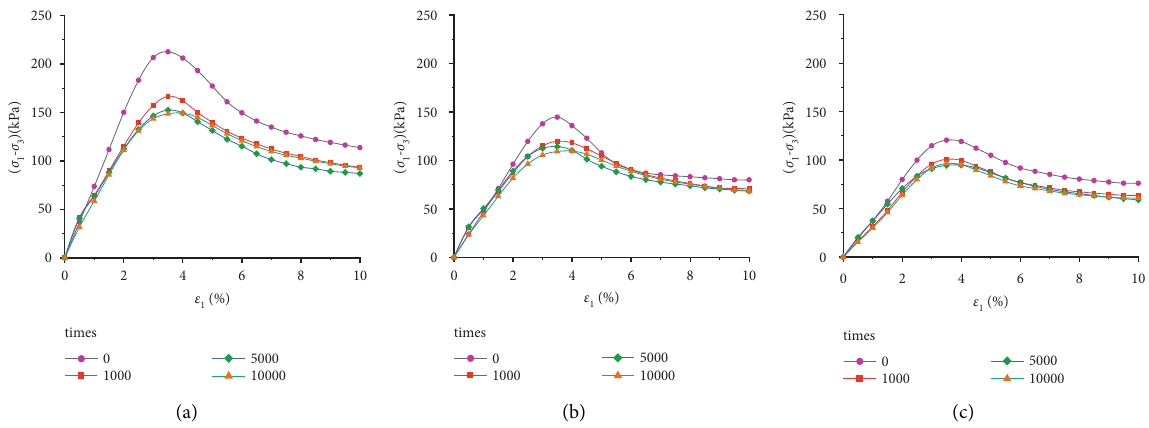
Figure 12: Stress-strain curves of the specimens under σ